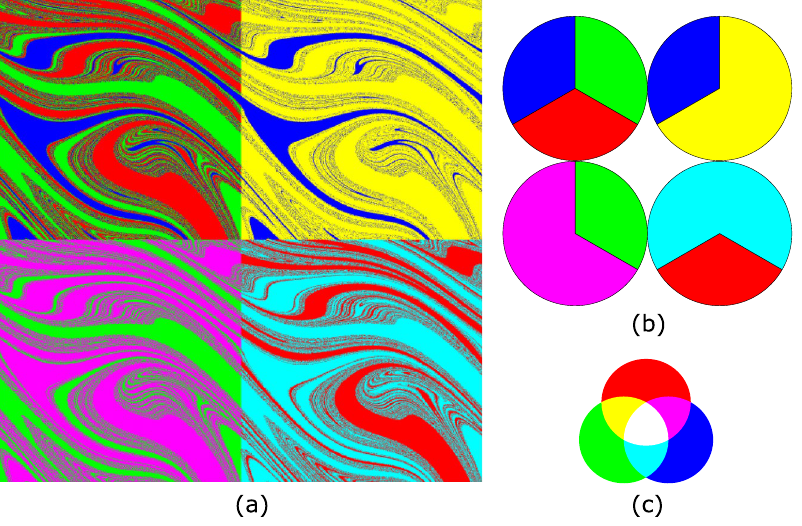
Figure 1. Merging Wada basins. The time-2 π (Poincaré) map of the forced damped pendulum defined by + . + = .  ̈ x x x t 0 2 sin 1 66cos possesses three attractors, and consequently its phase space  x x ( , ) contains three basins. This system verifies the Wada property 4 . ( a ) The top-left panel (in red, green and blue) represents the Wada basins, where one color corresponds to one basin. The other three panels are the result of the action of merging the basins: we merge two colors, and keep the third unchanged. ( b ) In the top-left panel a disk is divided in three colors. The other three panels show the action of merging in this non-Wada picture. ( c ) The color-code of the merged basins can be inferred from the bottom-right picture: yellow = red + green, magenta = blue + red, cyan = blue +